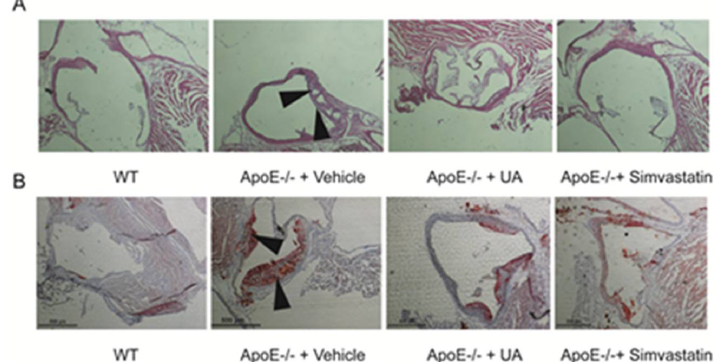
Figure 4. Aortic sinus sections were stained with Oil Red O and H&E to detect plaque sizes (40×) ( B ) and necrotic core areas (40×) ( A ), respectively. UA, ursolic acid; WT, wild type; ApoE −/− , apolipoprotein E-deficient.